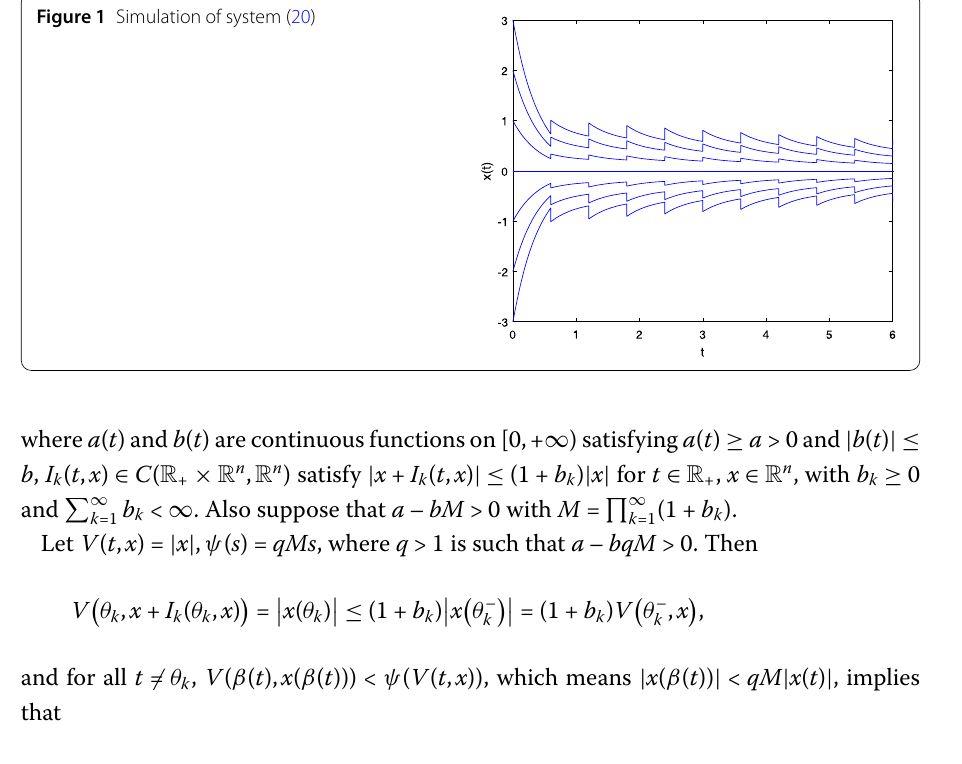
Figure 1 Simulation of system